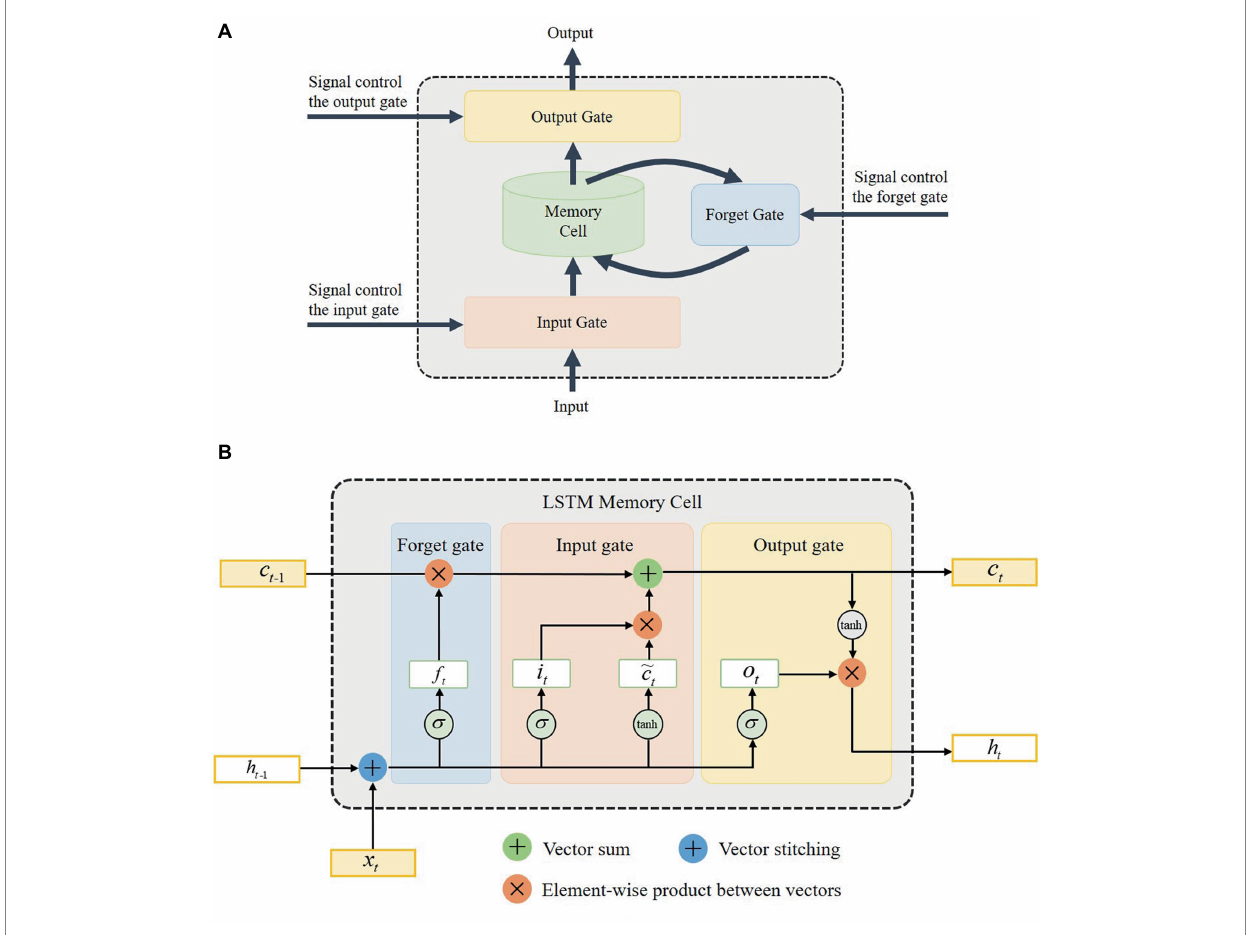
FIGURE 7 The architecture of the long short-term memory (LSTM) network. (A) The composition of LSTM memory blocks. (B) The structure of LSTM memory